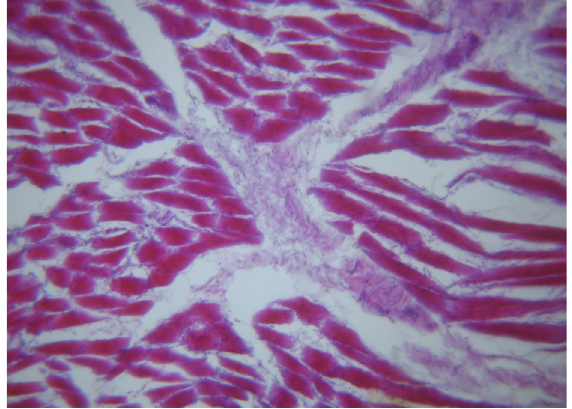
Figure 6. Microstructure of an ear tissue sample after processing with the ferment preparation Protepsin, magn. 400. (after 2 hours).